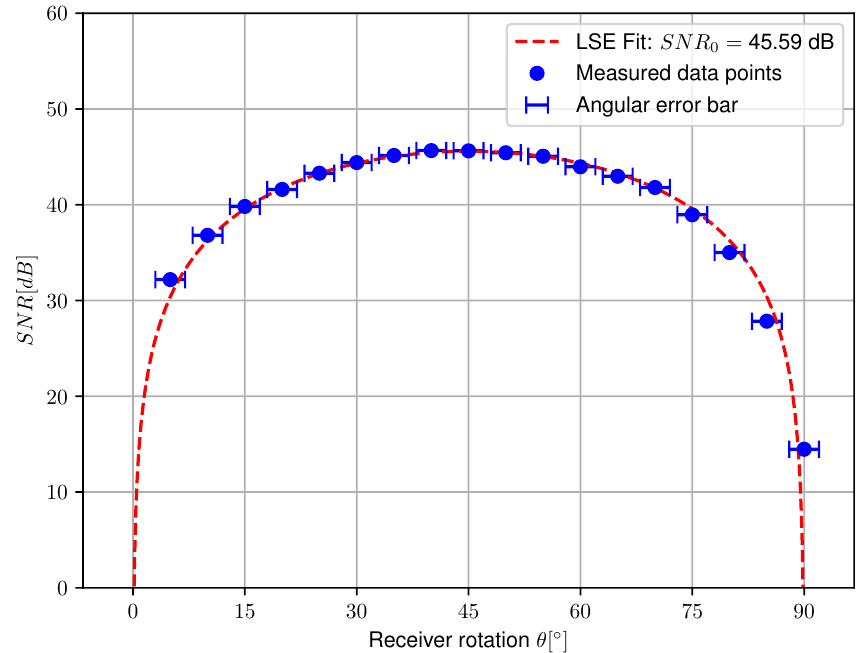
( c ) Measured SNR and theoretical fit as a function of receiver rotation θ at h = 1.35m for transmitted ‘1’-bits for QD C . setup B, receiver pair QD A −